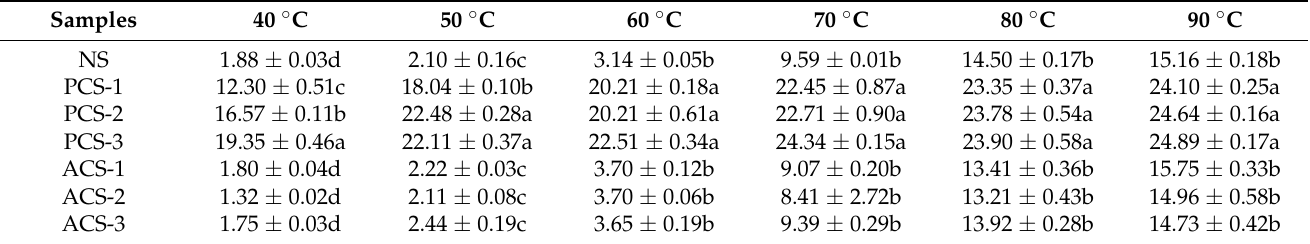
Table 2. Swelling power (g/g) of native, phosphorylated and acetylated chestnut